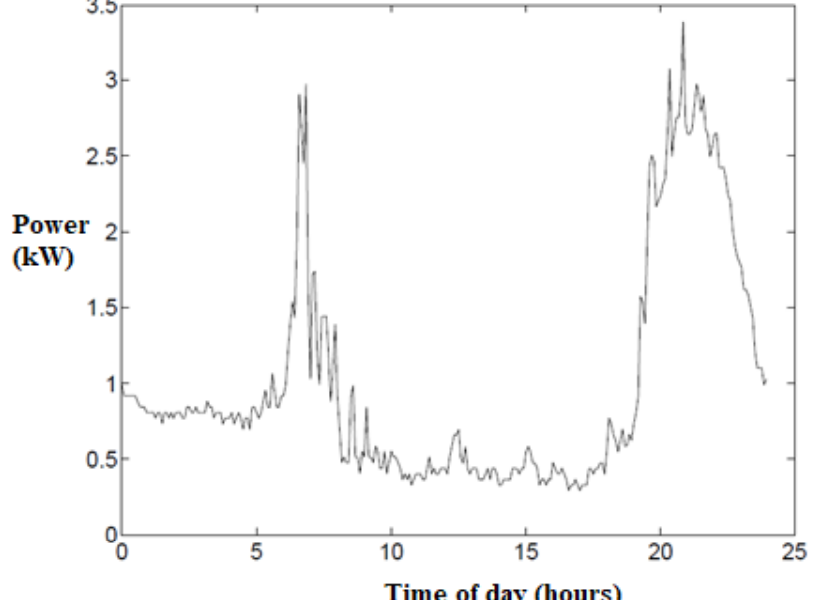
Figure 11. Measured load profile from [25].